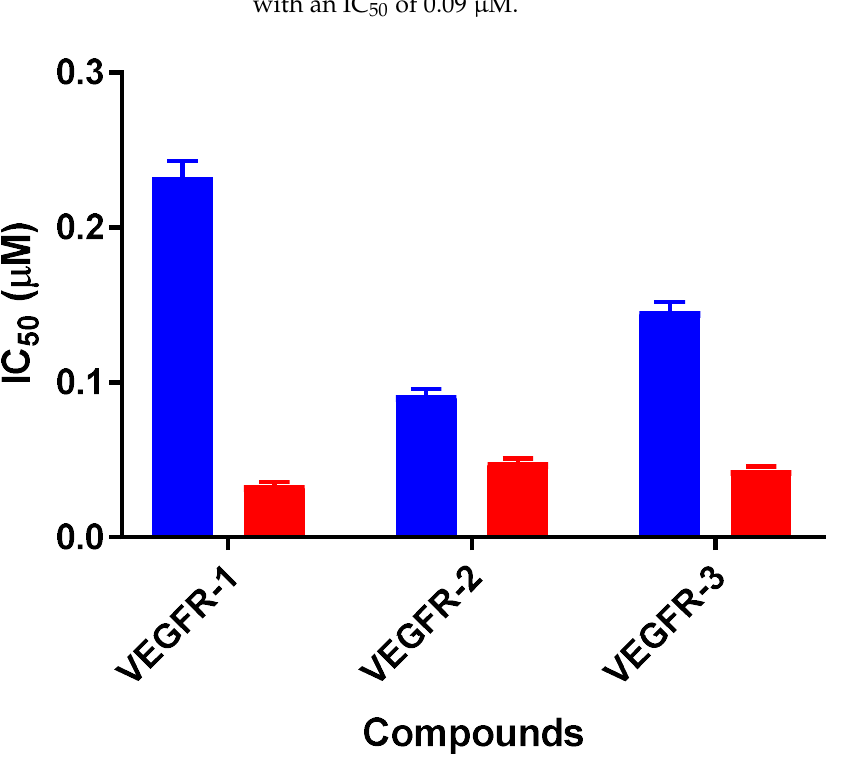
Figure 7. VEGFRx kinase selectivity profiles of 12b and the reference drug sorafenib.